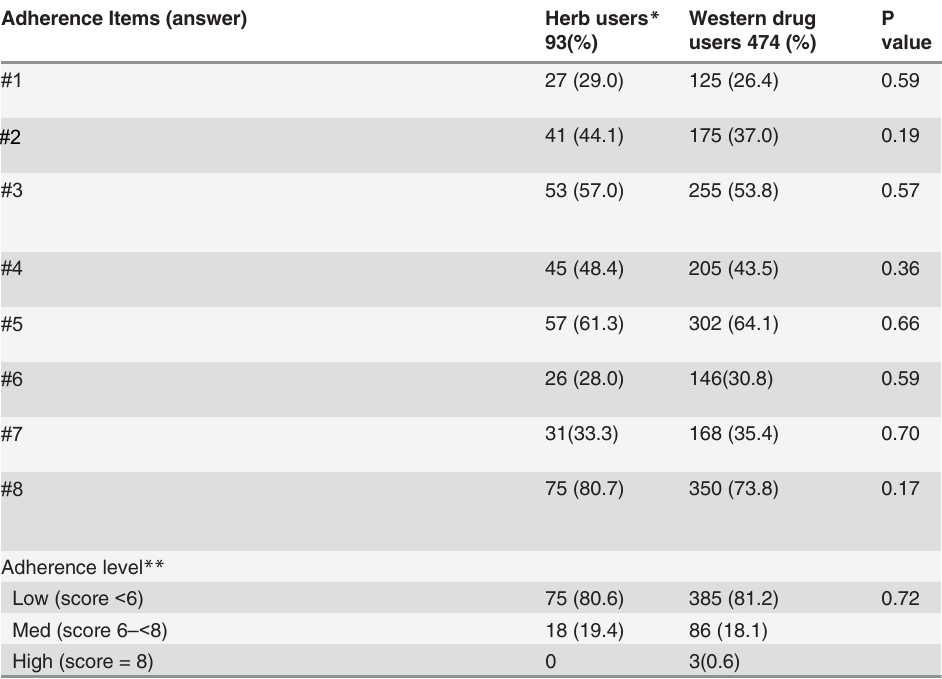
Table 4. Adherence rate of Chinese herbal therapy and western drug among patients with diagnosed